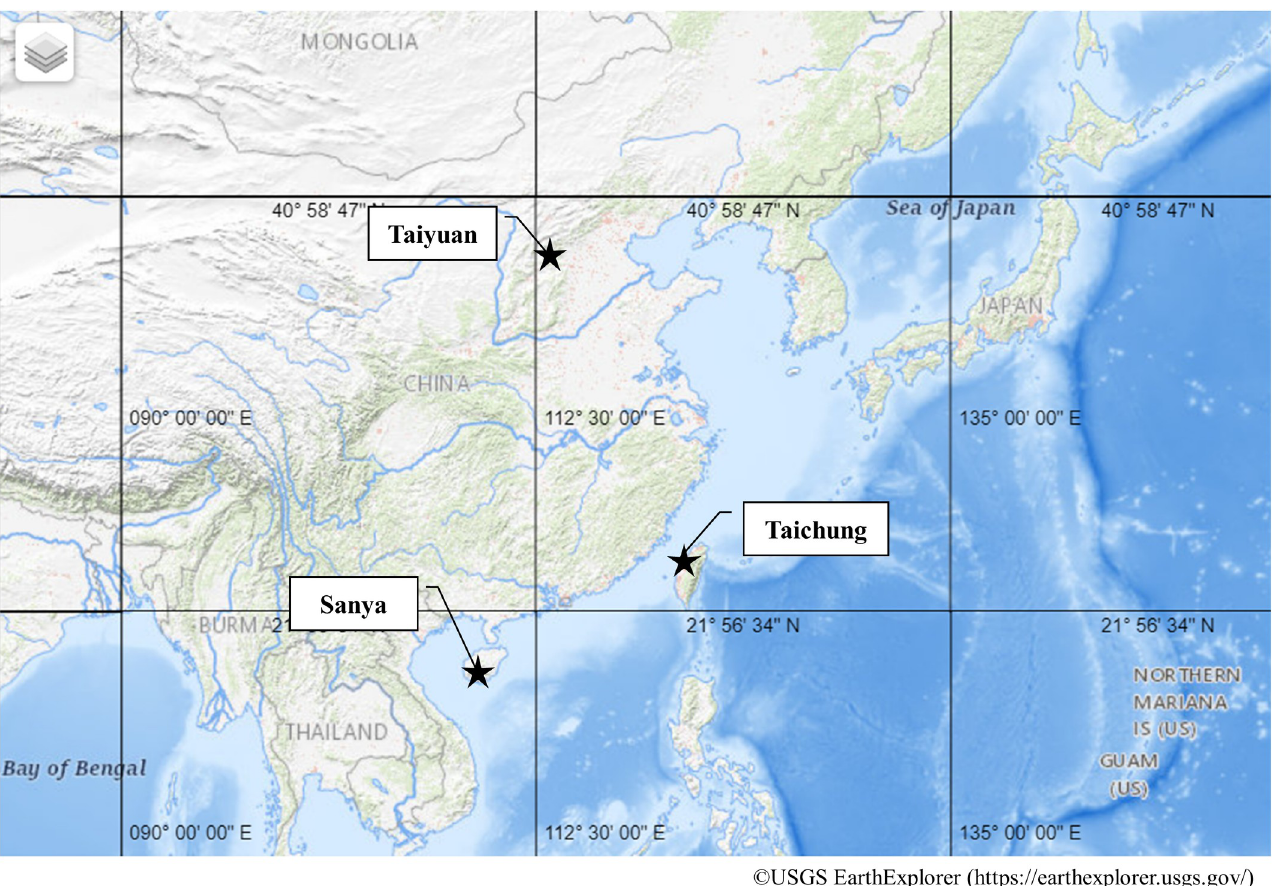
Fig 1. Locations of the three targeted regions. The map image resource is copyrighted by EarthExplorer of United States Geological Survey (USGS, https:// earthexplorer.usgs.gov/). https://doi.org/10.1371/journal.pone.0253093.g001 absence) in their right eye (444 in Sanya, 634 in Taiyuan, and 469 in Taichung). Because the pterygium prevalence of the right and left eyes did not significantly differ, the analysis was per- formed using the right eye (S1 Fig). The average age of participants was 60.4 ± 9.1 years (range 50–92). The axial length (AL) was measured using A-mode ultrasonography (NIDEK Inc., Fre-